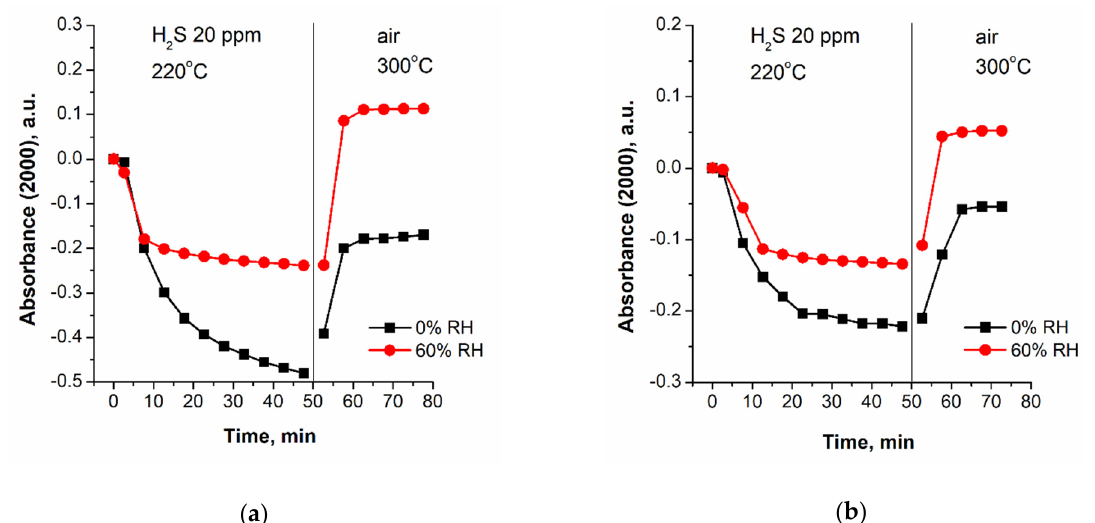
− 1 on DRIFT spectra: ( a ) Co 3 O 4 ; ( b ) Ni 0.1 Co 2.9 O 4